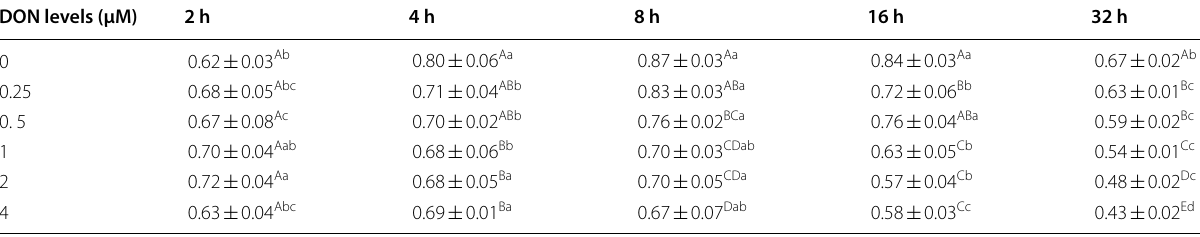
The different capital letters in the same columns indicated the significant differences for cell viability at the different DON concentrations ( p < 0.05), while the same capital letters in the same columns indicated the insignificant differences for cell viability at the different DON concentrations ( p > 0.05). The different lowercase letters in the same rows indicated the significant differences for cell viability at the different incubation time ( p < 0.05), while the same lowercase letters in the same rows indicated the insignificant differences for cell viability at the different incubation time ( p >